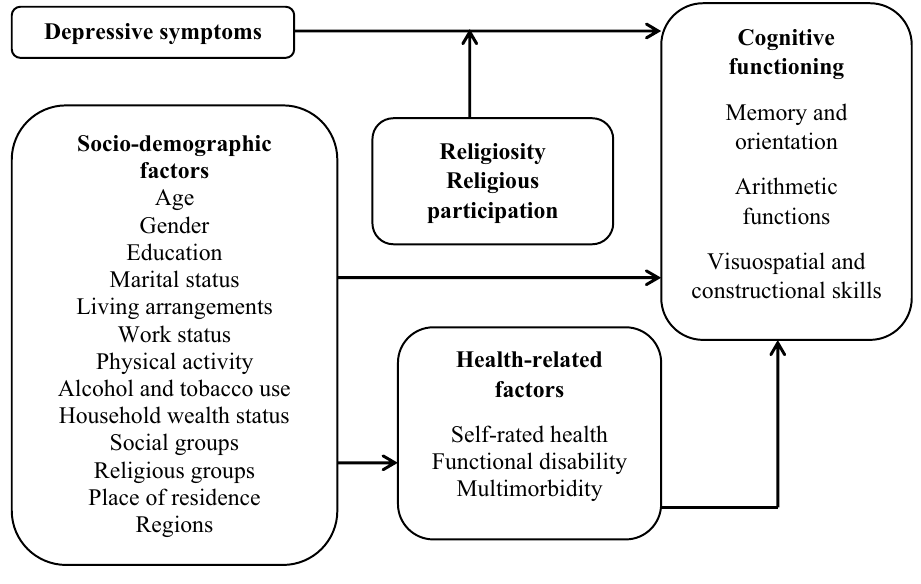
Figure 1. Conceptual model for the study.